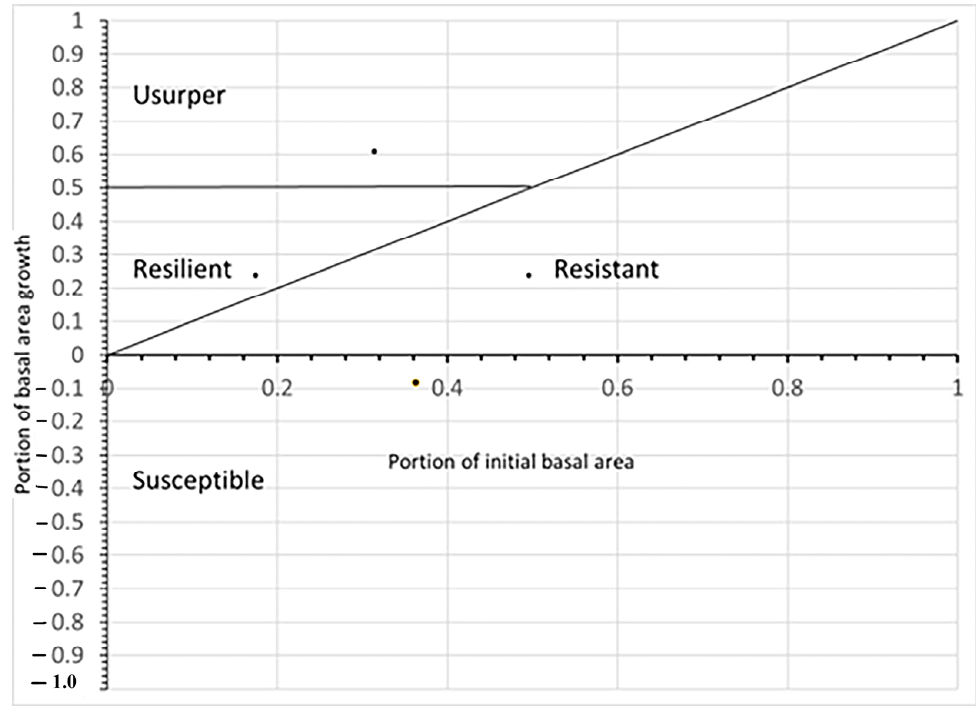
Figure 11. Revised version of the concept shown in Figure 1 modified to reflect the data collected in this study. In this analysis portion of the total growth represented by a species is compared to an initial portion of basal area rather than pre-disturbance growth.